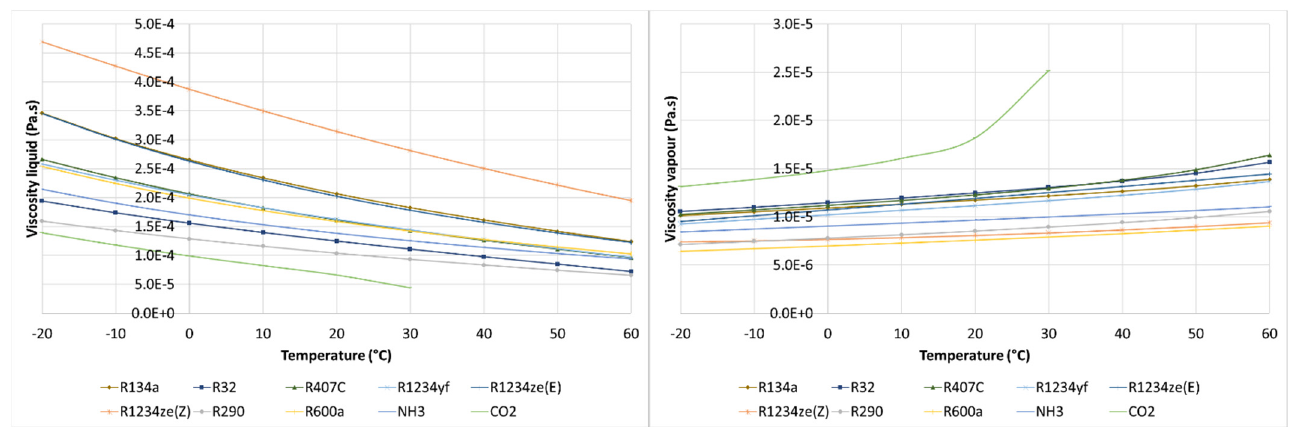
Figure 10. Comparison of evolutions of thermal conductivity depending on temperature.